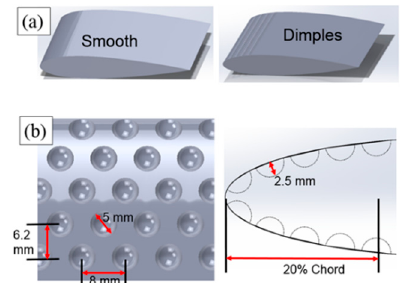
Figure 1. Test models and dimple geometry details. Adapted from Zhang et al. [2], Stolt et al. [30].